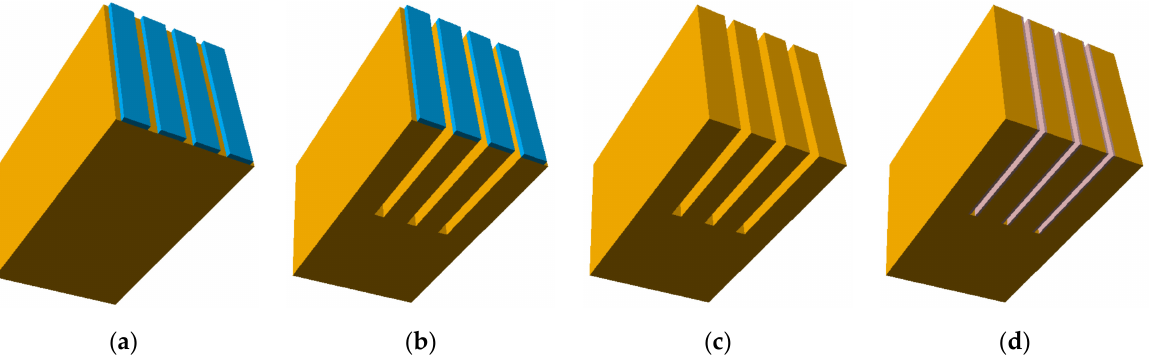
Figure 8. Proposed process flow of the partially-filled notches npn microstructure ( a ) photoresist deposition, ( b ) deep etching, ( c ) after removing photoresist, and ( d ) after defining side wall emitter contact.